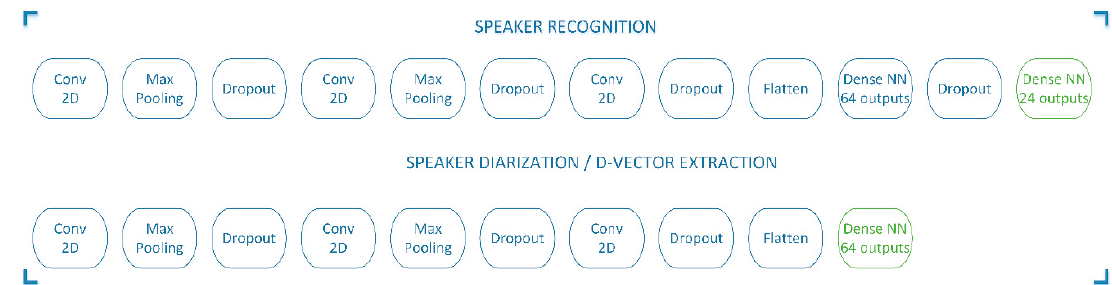
Figure 5. The architecture of the convolutional neural network used for speaker recognition. The last two layers of the trained model are discarded to be used for d-vector extraction for speaker diarization.